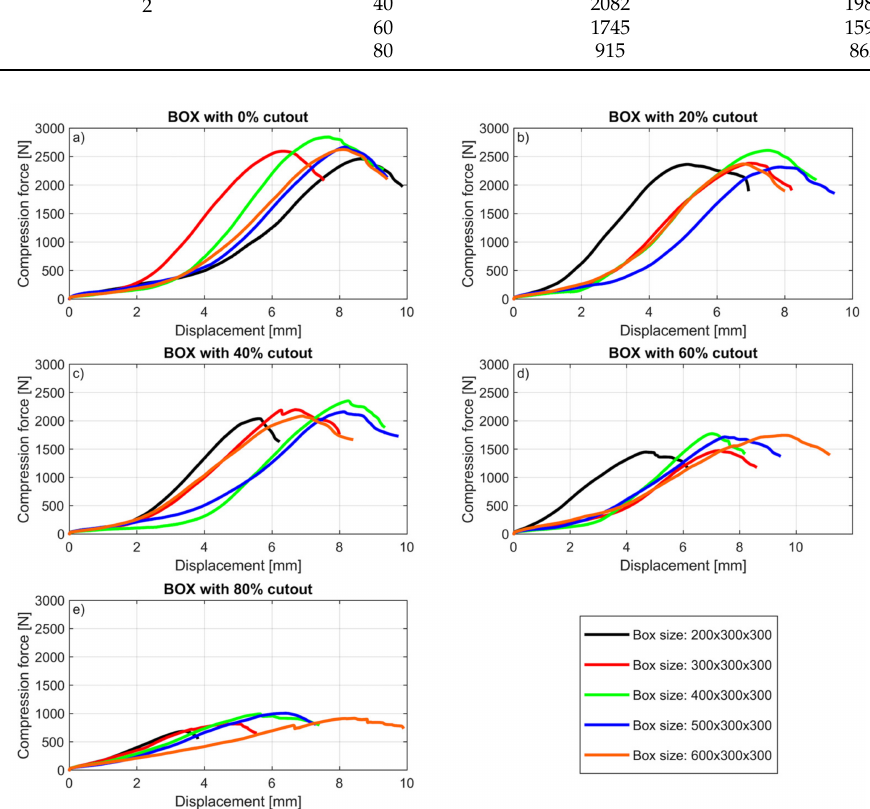
Figure 7. Maximum force–compression diagrams according to cutout ratios: ( a ) 0% cutout ratio; ( b ) 20% cutout ratio; ( c ) 40% cutout ratio; ( d ) 60% cutout ratio; ( e ) 80% cutout